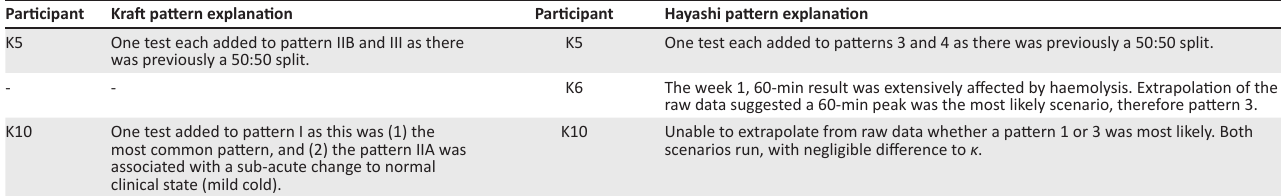
TABLE 5: Kraft and Hayashi pattern frequencies on eight participants over four visits per person after imputation. Participant Kraft pattern